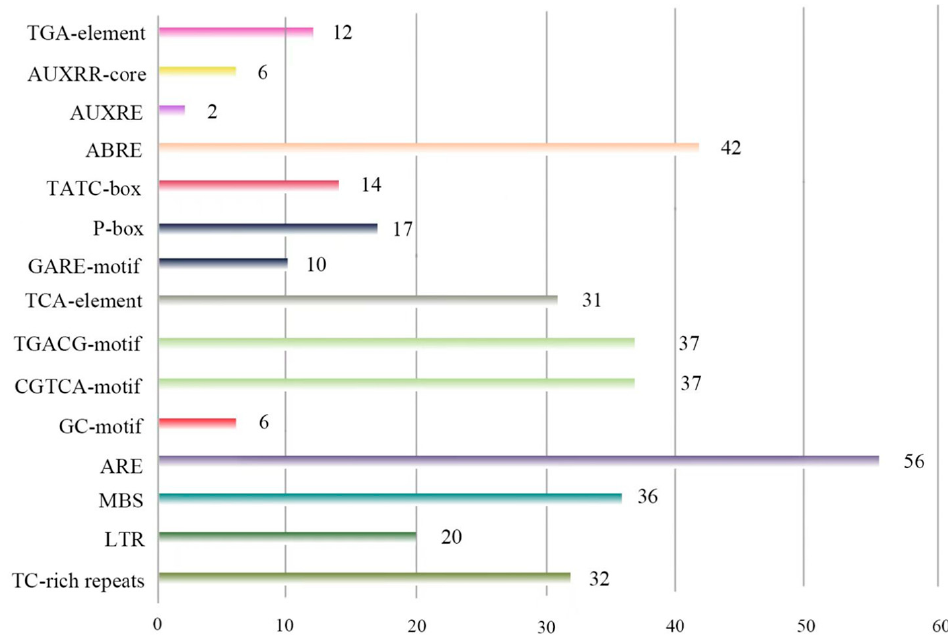
Figure 4. Numbers of CsSAUR genes containing di ff erent cis-acting elements.